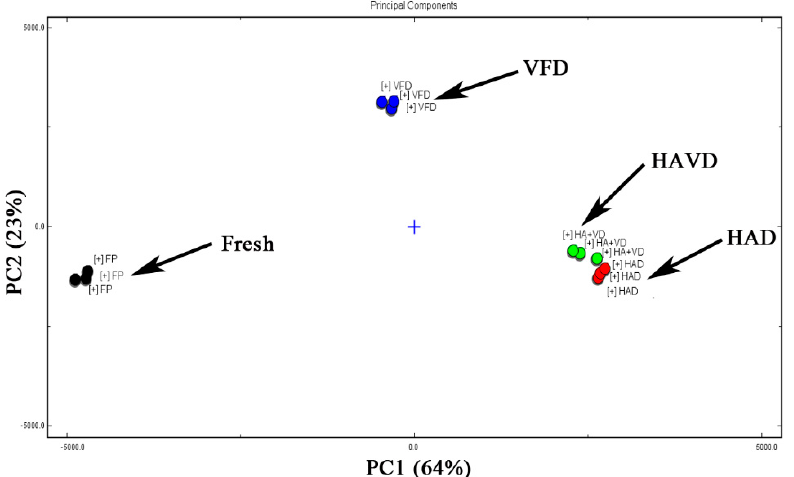
Figure 5. PCA analysis of flavor volatile components of L. decastes treated by different drying methods. HAD: hot − air − drying sample; HAVD: hot − air − combined − with − vacuum-drying sample; VFD: vacuum − freeze − drying sample.